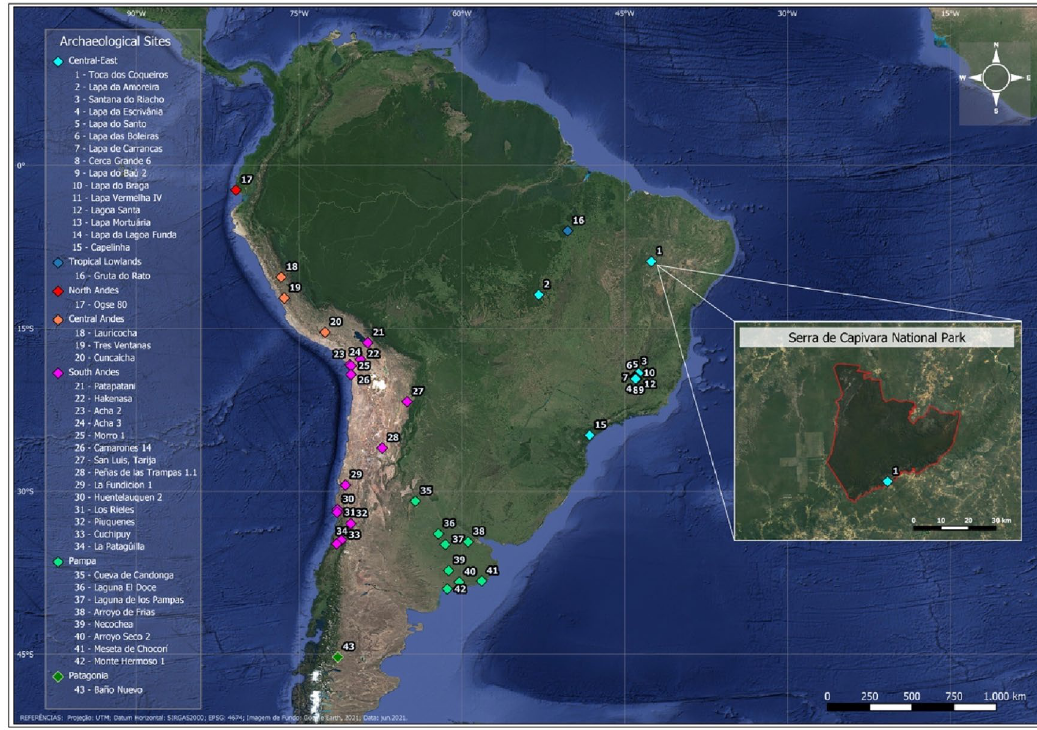
Figure 1. Archaeological sites from South America with direct early Holocene radiocarbon dates on human skeletons. The detailed figure shows the location of Toca dos Coqueiros site in the Serra da Capivara National Park. Color references indicate regions within South America. See Table S1 for a full list and information on the sites. Figure generated by extracting a map with UTM projection from Google Earth (https:// earth. google. com/ web/) and adding the location of the archaeological sites by using geographic coordinates with QGIS v.3.22.5 LTR (https:// qgis. org/ en/